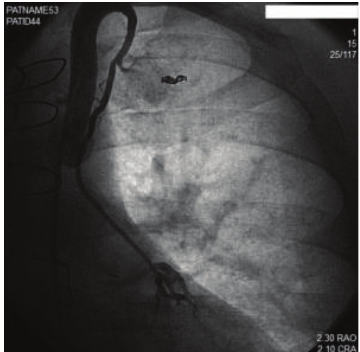
Figure 5: Angiogram of the LIMA showing successful microem- bolizationofthethoracicsidebranchafterplacementof4microcoils with concomitant significant increase in LIMA